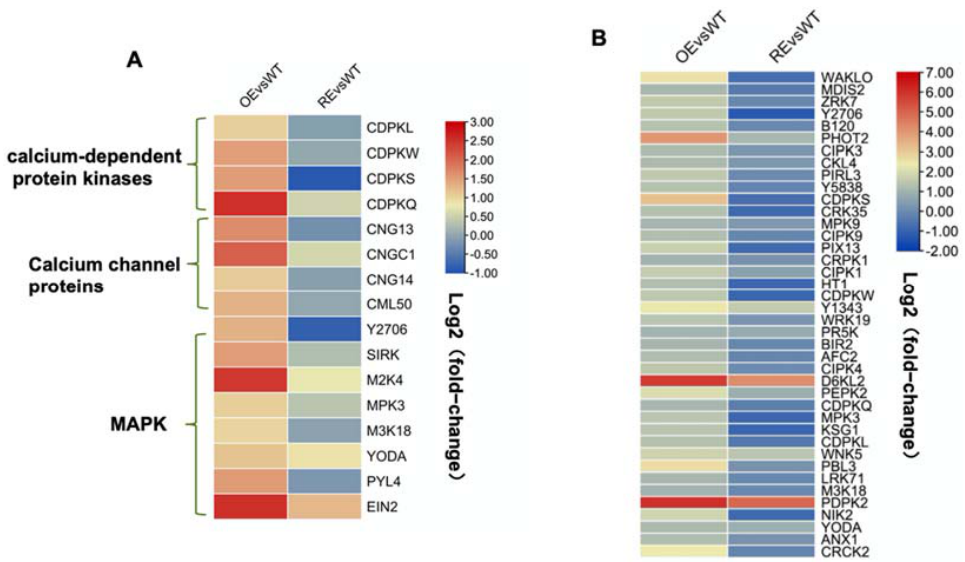
Figure 4. Expression of immune-related genes in PsnWRKY70 transgenic line. ( A ) KEGG enriched genes in the plant–pathogen interaction pathway. ( B ) GO enriched genes in the protein phosphorylation pathway.